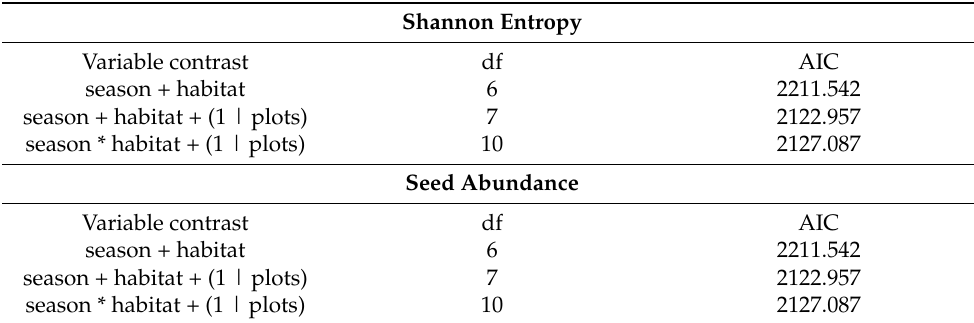
Table 2. Generalized Linear Model comparison for Shannon entropy and seed abundance in the topsoil seed bank on the basis of AIC.